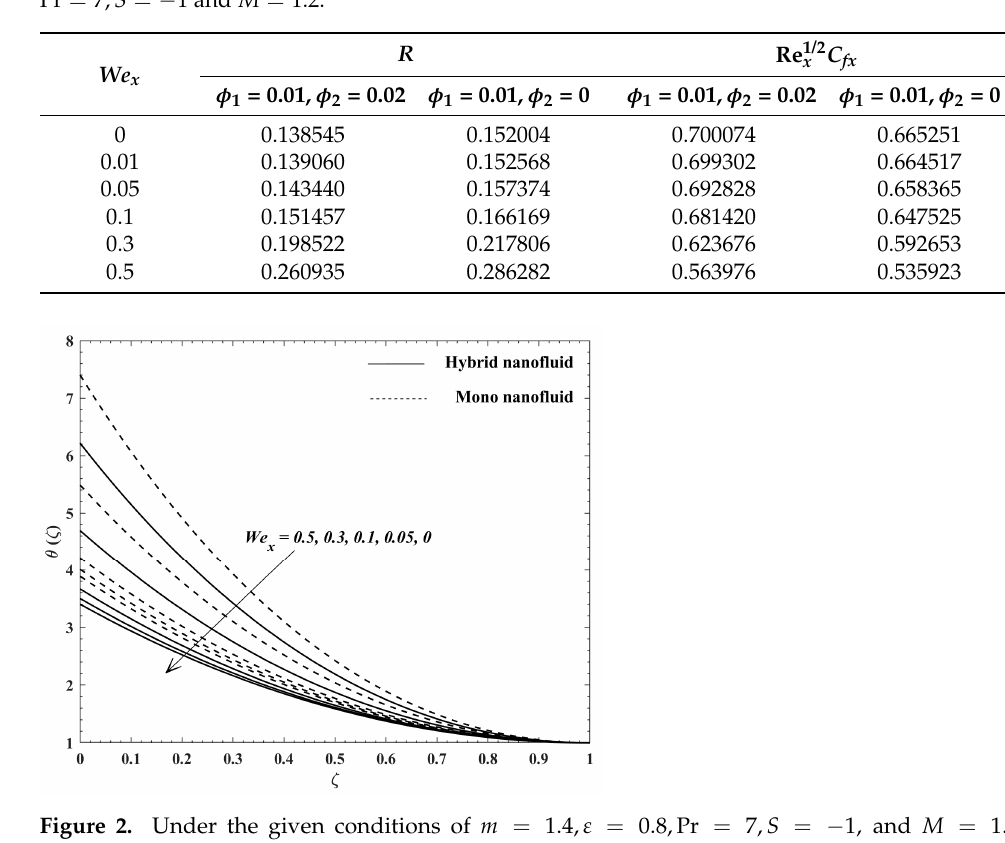
Table 5. As the local Weissenberg number are made for the local Nusselt number